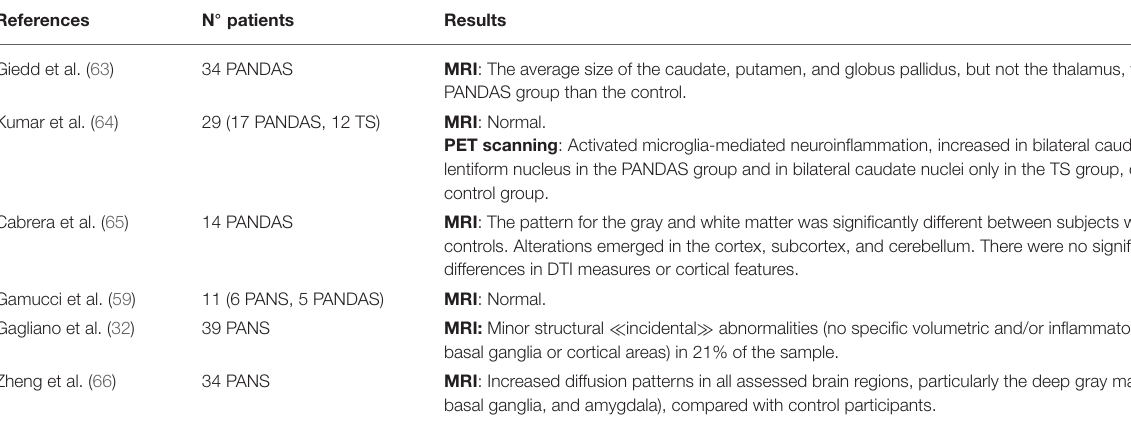
TABLE 4 | Neuroimaging studies in patients with PANDAS or PANS.